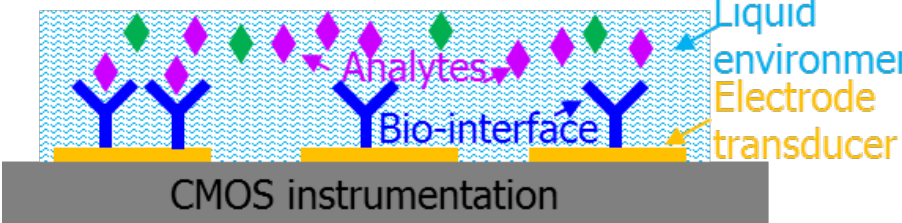
Figure 1. Components of a general integrated electrochemical biosensor.